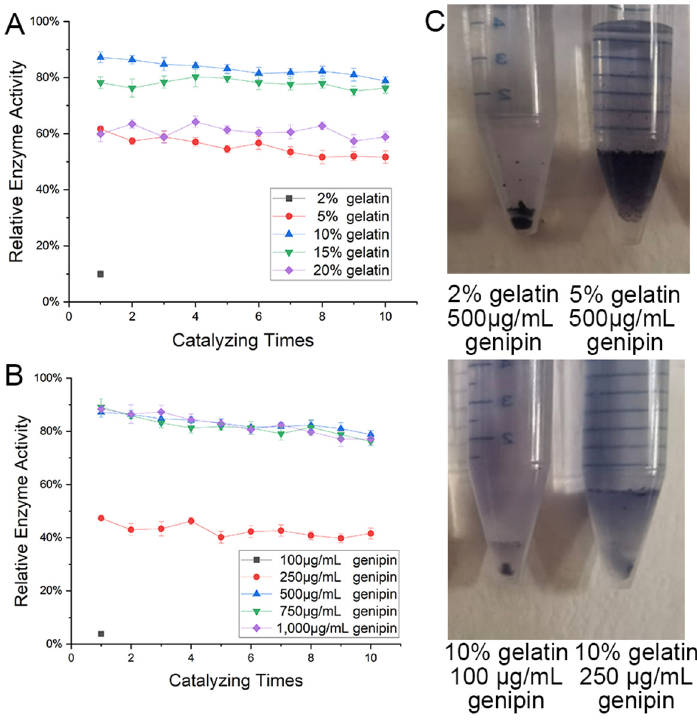
Figure 3. Relative enzyme activities of hydrogels with different concentrations of gelatin and genipin. ( A ) Relative enzyme activities of hydrogels with different concentrations of gelatin; the concentration of genipin was 500 µg/mL. Crude Dac solution (free enzyme) was used as the reference of enzyme activity, the same below. ( B ) Relative enzyme activities of hydrogels with different concentrations of genipin; the concentration of gelatin was 10% ( w / v ). ( C ) Image of “2-500”, “5-500”, “10-100”, and “10-250” hydrogels after the washing. Here, “a-b” represented the hydrogel with “a%” gelatin and “b µg/mL” of genipin.